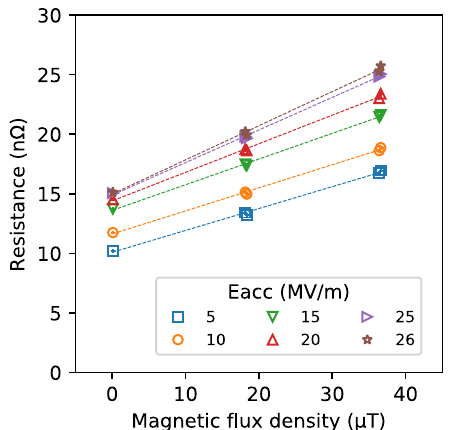
FIG. 14. Relationship between the applied magnetic field and surface resistance of the cavity with locally trapped magnetic flux. The horizontal axis is the absolute strength of the magnetic field and the vertical axis is the surface resistance of the cavity obtained via rf measurement. The surface resistance is propor- tional to the applied magnetic field at each accelerator gradient.